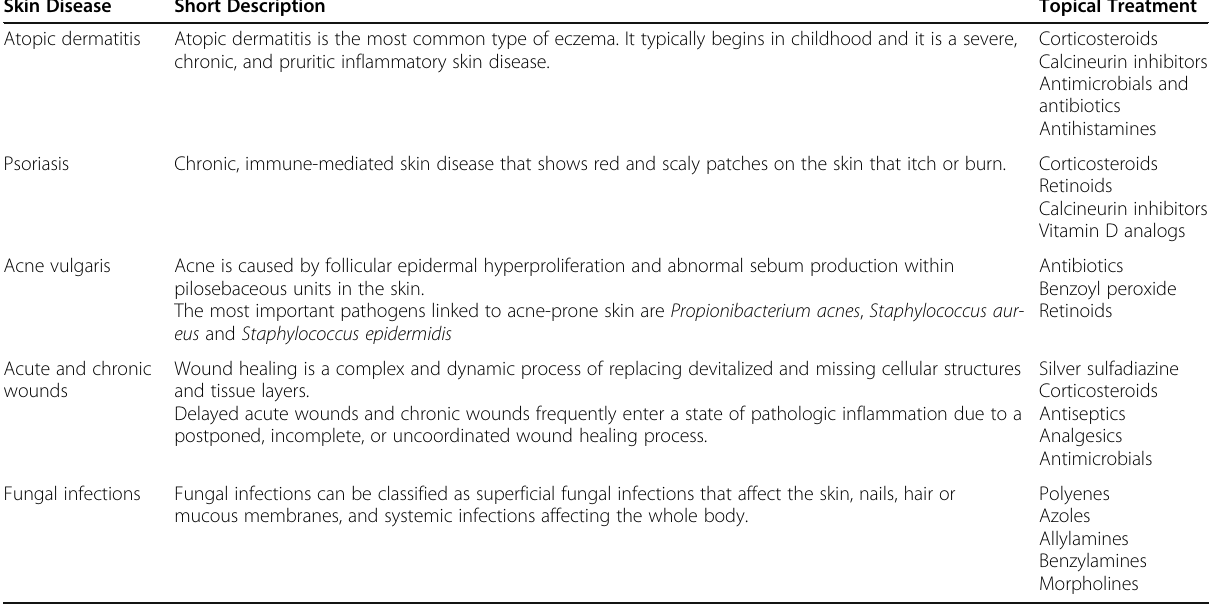
Table 1 Common skin disorders and existing topical treatment options Skin Disease Short